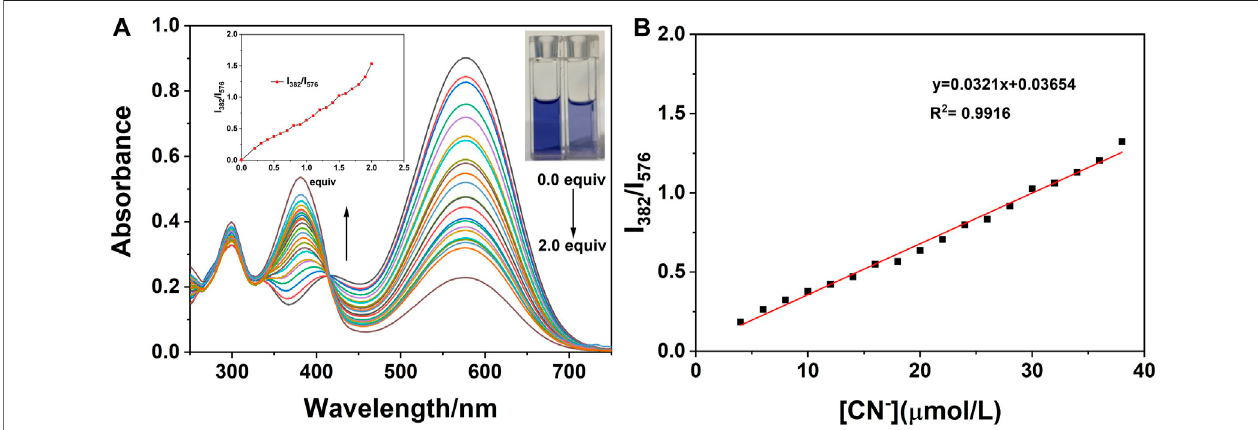
FIGURE 7 | (A) UV-Vis absorption spectra on the addition of CN − to the probe; (B) linear relationship between the ratio of absorbance at 382 – 576 nm and the concentrations of CN − (4~38 μ M). Inset: the change curve of the ratio of absorbance at 382 – 576 nm with different concentrations of CN − ; photograph of the solutions under illumination with sunlight showing the change of the solution after the titration is complete.